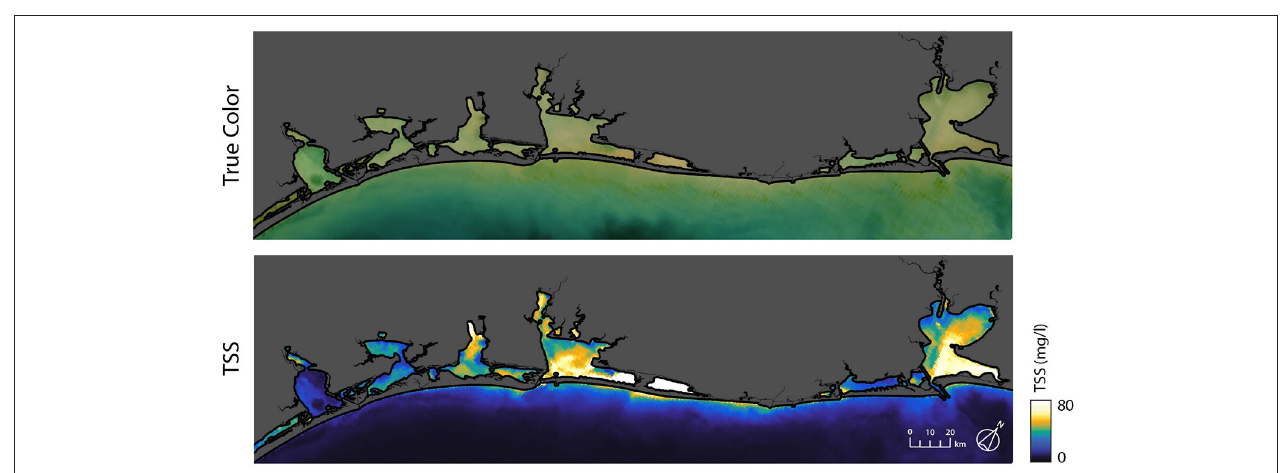
FIGURE 5 | MODIS-Aqua 500-m True Color RGB image and example of output from TSS algorithm for same scene following the passage of a cold front on January 10th 2006.